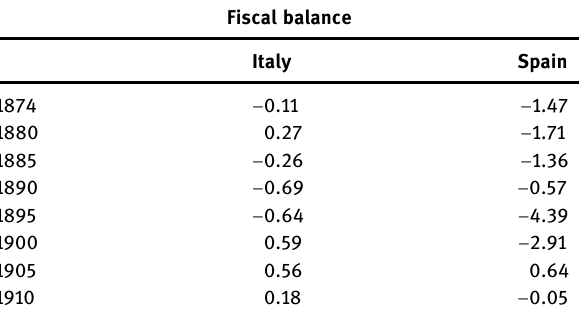
Table 3: Fiscal balance over GDP in Italy and Spain ( % )